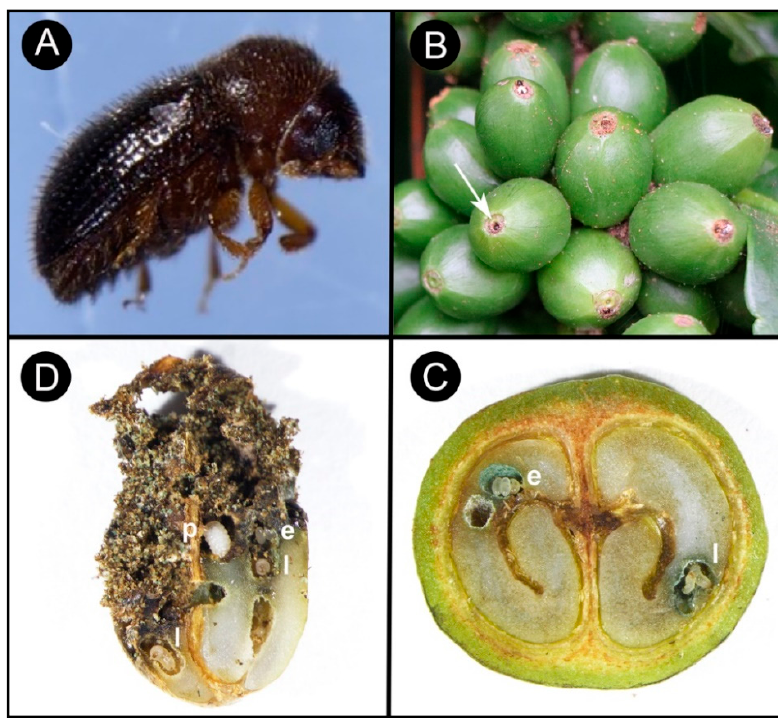
Figure 1. The coffee berry borer life cycle: ( A ) adult female coffee berry borer; ( B ) entrance hole with female coffee berry borer (CBB) (arrow) in the central disc of the developing green coffee berries; also note the presence of entomopathogenic fungus Beauveria bassiana (white mycelium protruding from female CBB); ( C ) reproductive galleries containing eggs (e) and larvae (l) in the coffee bean; ( D ) advanced stages of bean damage due to larval feeding, with pupae (p), larvae (l), and eggs (e) visible. As with other insects of economic importance, research is the key to improved management of